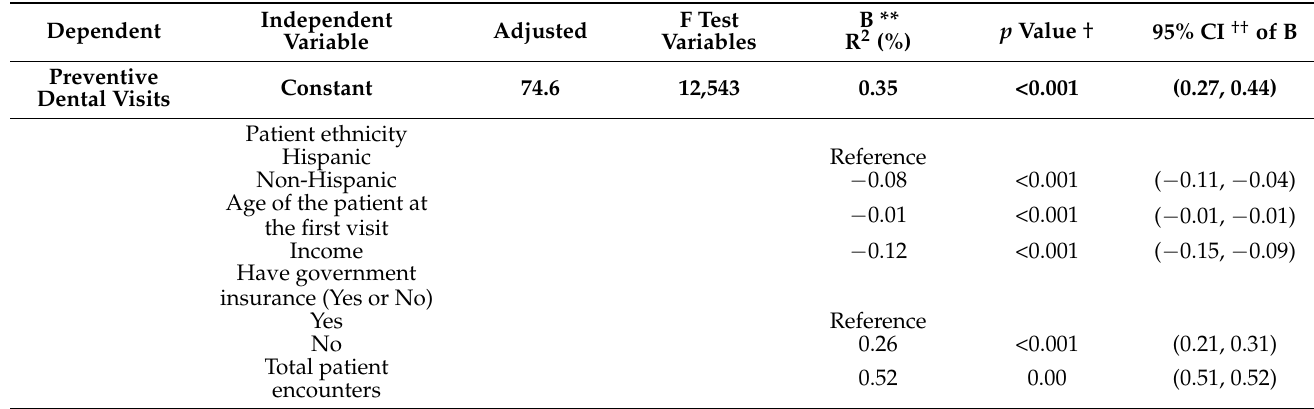
Table 2. Understanding the Impact of the Patient Ethnicity on the Preventive Dental Visits Using the Multiple Linear Regression